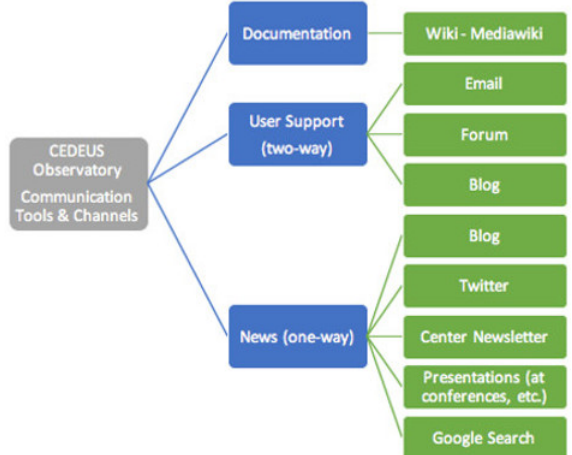
Figure 5. CEDEUS SDI communication tools by type of